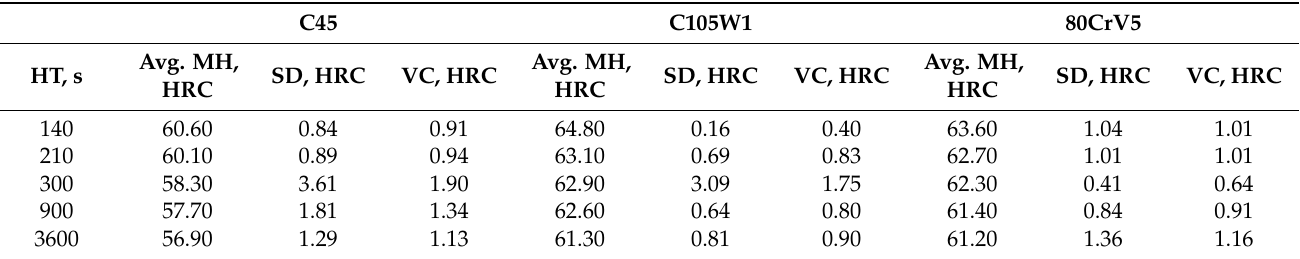
Table 3. C45, C105W1, and 80CrV5 steel sample hardness at the selected heating